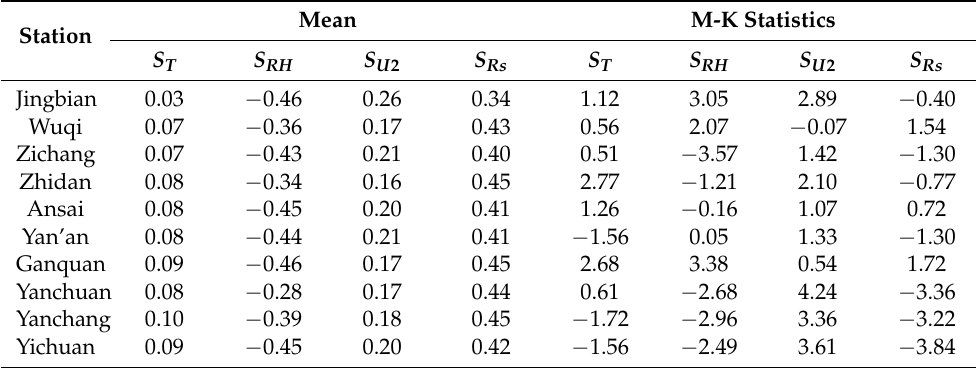
Table 3. M-K statistics of Sensitivity coefficient of ET 0 to meteorological factors of Yanhe River